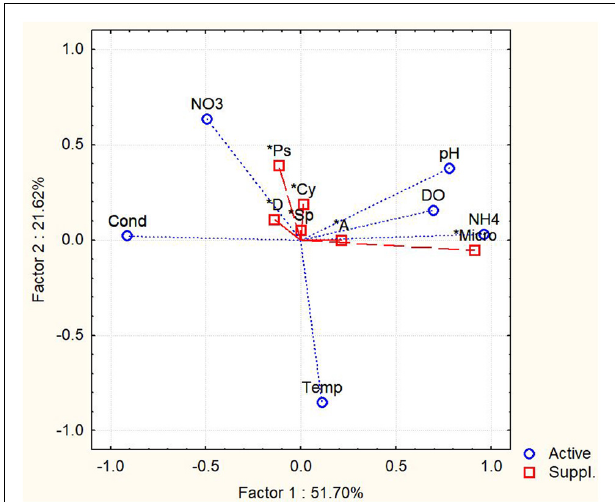
FIGURE 5 | Principal component analysis (PCA) of abundances of potentially toxic cyanobacteria and environmental factors. Temp, temperatures; Cond, conductivity; NO 3 , concentration of nitrates; NH 4 , ammonium concentration; Micro, Microcystis sp.; A, Aphanizomenon / Cuspidotrix sp.;